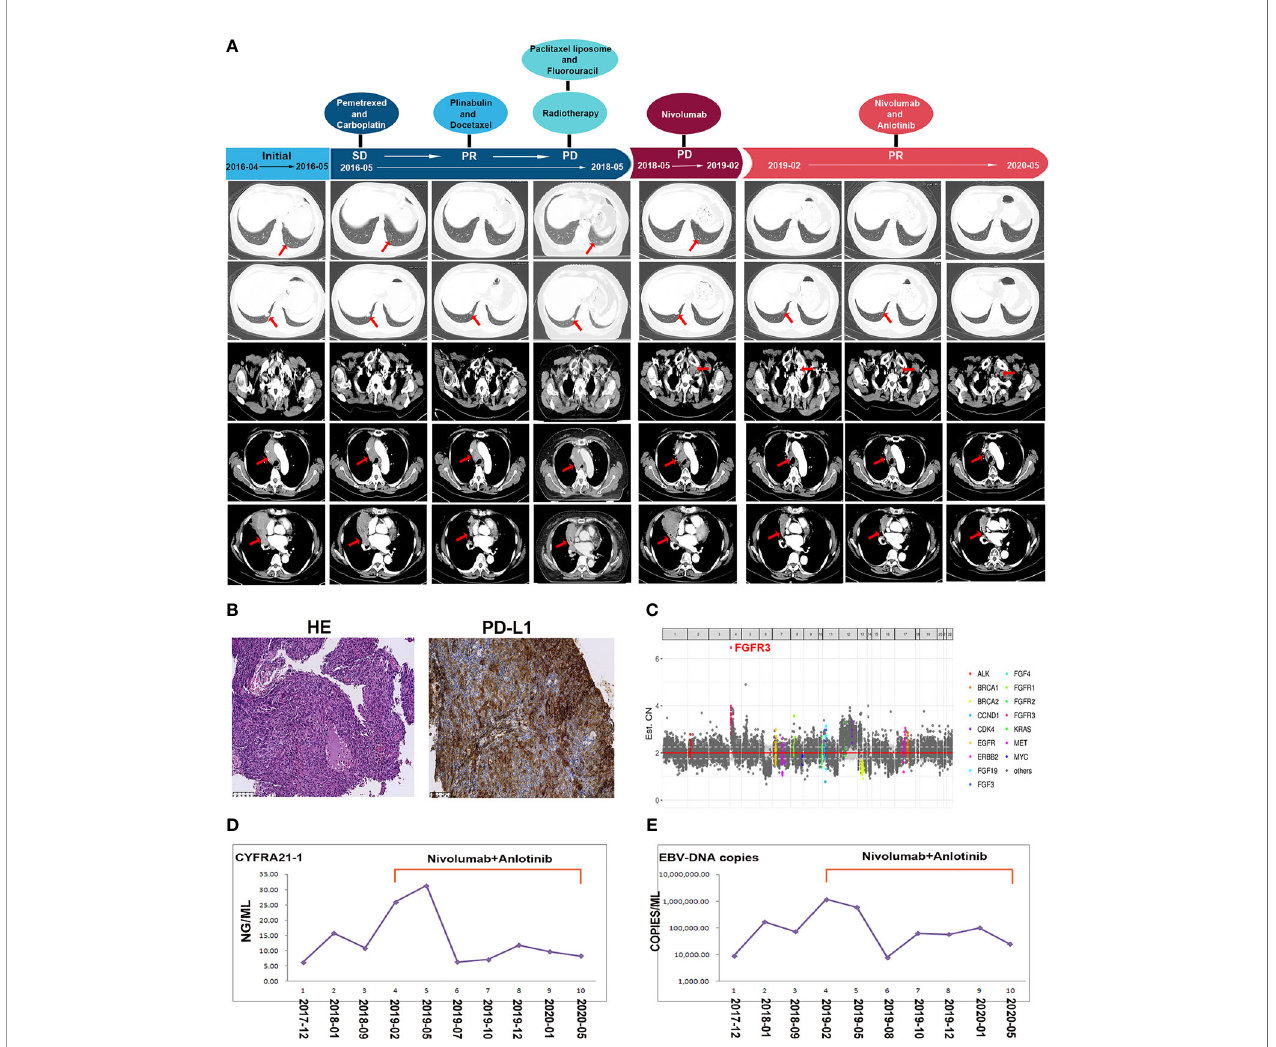
FIGURE 1 | (A) Schematics show the treatment history of the patient. Enhanced computed tomography scan reveals the clinical response to chemotherapy, radiotherapy, nivolumab alone, and nivolumab combined with anlotinib. Red arrows point to the masses in pulmonary and lymph node metastases. (B) Immunohistochemistry presents the programmed death ligand-1 expression of the lymphoepithelioma-like carcinoma (LELC) tissues in pulmonary LELC. (C) The genetic testing result of the new metastatic lymph node in our patient, when her disease progressed after nivolumab monotherapy. (D) The curves showed serum tumor marker CYFRA21-1 levels before and after the combined nivolumab and anlotinib therapy. (E) The curves showed Epstein – Barr virus copy numbers in the serum before and after the combined nivolumab and anlotinib